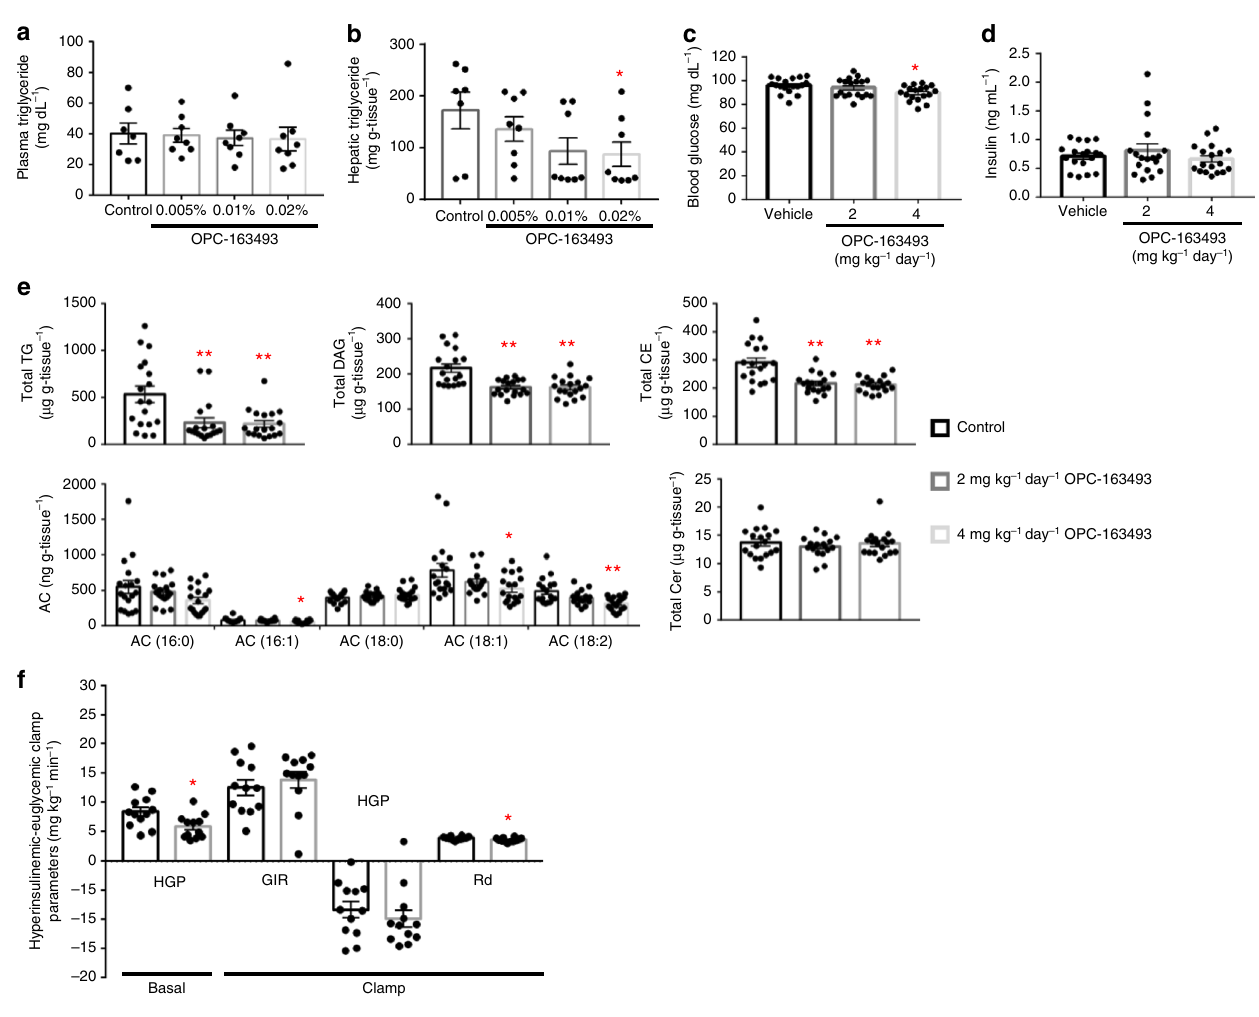
Fig. 3 Antisteatotic effect and hyperinsulinemic-euglycemic clamp test. a , b Effect of OPC-163493 dosing with mixed chow on plasma ( a ) and hepatic ( b ) triglyceride (TG) in male ob/ob mice. Data represent mean ± SE (control group: n = 7, other groups: n = 8). No signi fi cant difference was found in plasma TG using a two-tailed Williams ’ test. A signi fi cant difference was found in hepatic TG between control and 0.02% OPC treatment groups using a two-tailed Williams ’ test ( ∗ P < 0.05). Control chow and OPC-163493 admixed chow were fed to each animal group for 10 weeks from the age of 8 weeks. c , d Effect of OPC-163493 on fasting blood glucose ( c ) and plasma insulin ( d ) levels in HFD SD Rats. Data represent mean ± SE ( n = 18). Signi fi cant ef fi cacy was found in the 4 mg kg − 1 day − 1 OPC-163493-treated groups in blood glucose but not in plasma insulin ( ∗ P < 0.05 OPC vs. vehicle group by Dunnett ’ s test). e Effect of OPC-163493 on hepatic lipids in HFD SD Rats. Data represent mean ± SE ( n = 18). ∗ P < 0.05, ∗∗ P < 0.01 OPC vs. vehicle group by Dunnett ’ s test. Black bar, control; gray bar, 2 mg kg − 1 day − 1 ; silver bar, 4 mg kg − 1 day − 1 . SD rats were fed with 60 kcal% fat chow for 2 weeks from the age of 10 weeks ZDF(M) rats were fed ad libitum with 0.04% OPC-163493 mixed chow or control chow for 3 weeks from the age of 7 weeks. Data represent mean ±